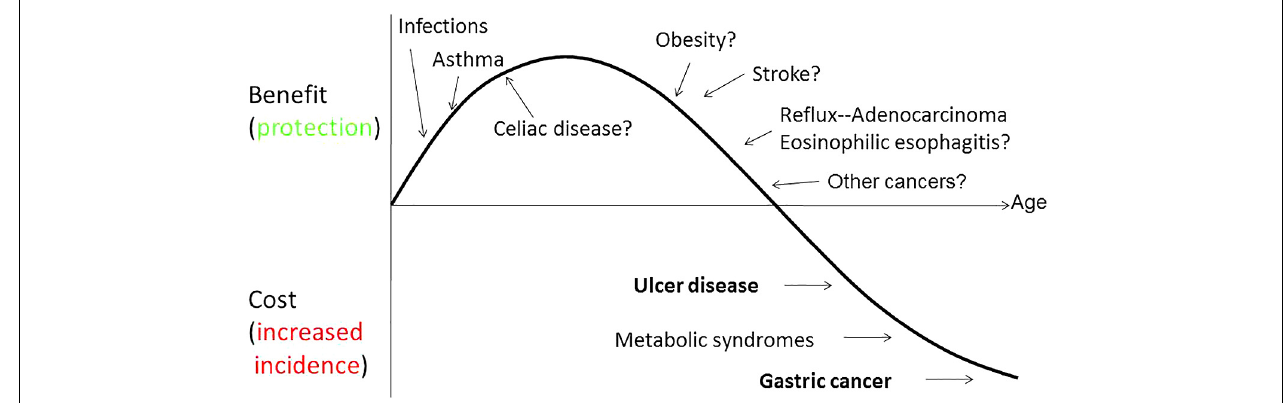
FIGURE 6 | Model of the biphasic nature of H. pylori interaction with humans (Atherton and Blaser,